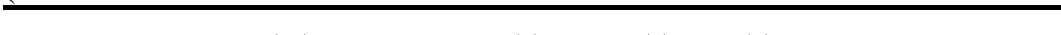
Fig. 3 – Excitation-contraction (EC) coupling in non-failing (A) and failing (B) hearts. (A) In non-failing hearts during systole EC coupling involves depolarization of the transverse tubule (T-tubule), which activates voltage-gated L-type Ca ++ channels (I Ca ) in the plasma membrane. Additional Ca ++ influx can occur through reverse-mode Na + /Ca ++ exchanger (NCX rev). Ca ++ influx via I Ca triggers Ca ++ release from the sarcoplasmatic reticulum (SR) via ryanodyne channels (RYR). During diastole, intracellular Ca ++ is pumped out of the cytoplasm by the SR Ca ++ ATPase (SERCA), which is regulated by Phospholamban (PLB). The ’P’ on PLB indicates that when phosphorylated, PLB release SR inhibition. In addition, Ca ++ is extruded from the cell by the sarcolemmal NCX. The β -adrenergic receptor ( β AR) activation increases EC-coupling gain during systole and diastole through phosphorylation, via protein kinase A, of I Ca , RYR, PLB. (B) In failing hearts EC-coupling altered. RYR are hyperphosphorylated by PKA, which leads to greater sensitivity to Ca ++ induced Ca ++ release at low and moderate cytoplasmic Ca ++ concentrations. The long-term effect of PKA hyperphosphorylation of RYR is an increased open probability at low intracellular Ca ++ concentrations, consistent with Ca ++ leakage during diastole. In addition SERCA is downregulated, while NCX is upregulated in failing hearts, which contributes to depletion of SR Ca ++